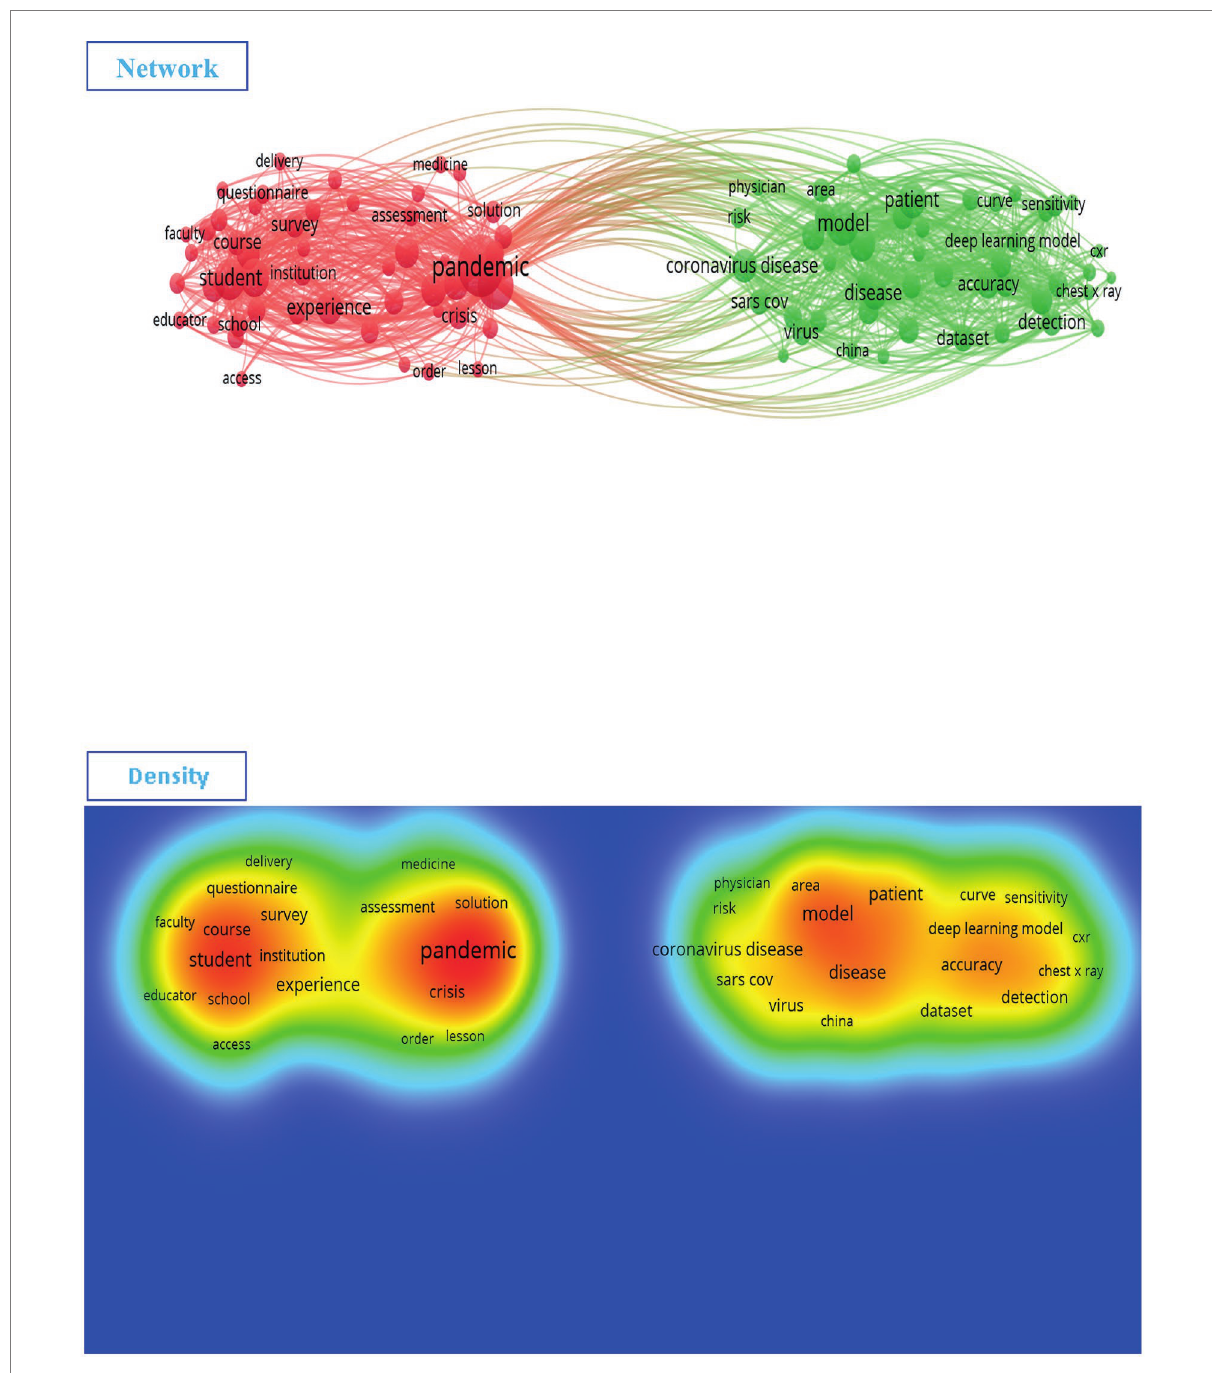
FIGURE 4 The network and density of keywords depend on Web of Science (VOSviewer